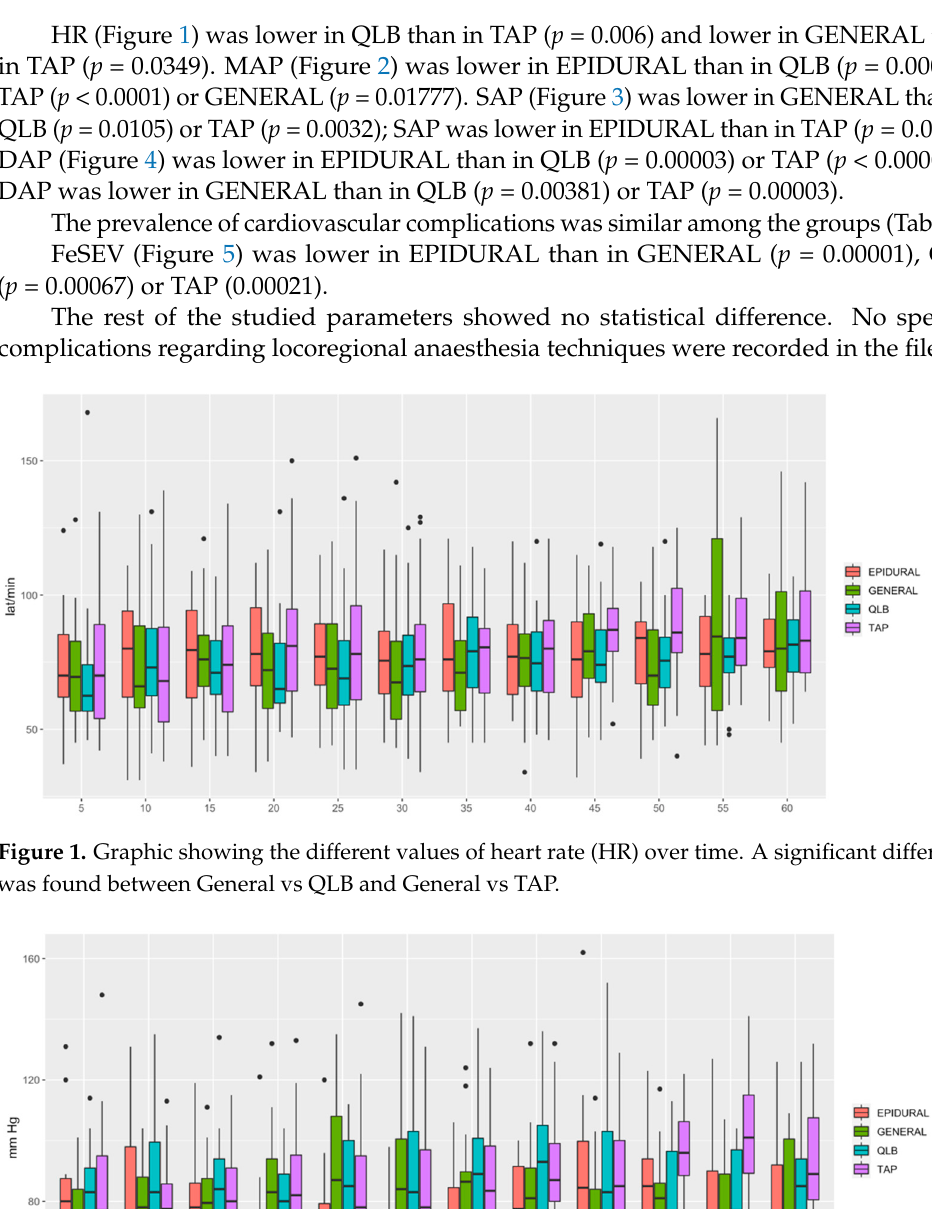
. . Figure 3. Graphic showing the different values of systolic arterial pressure (SAP) over time.